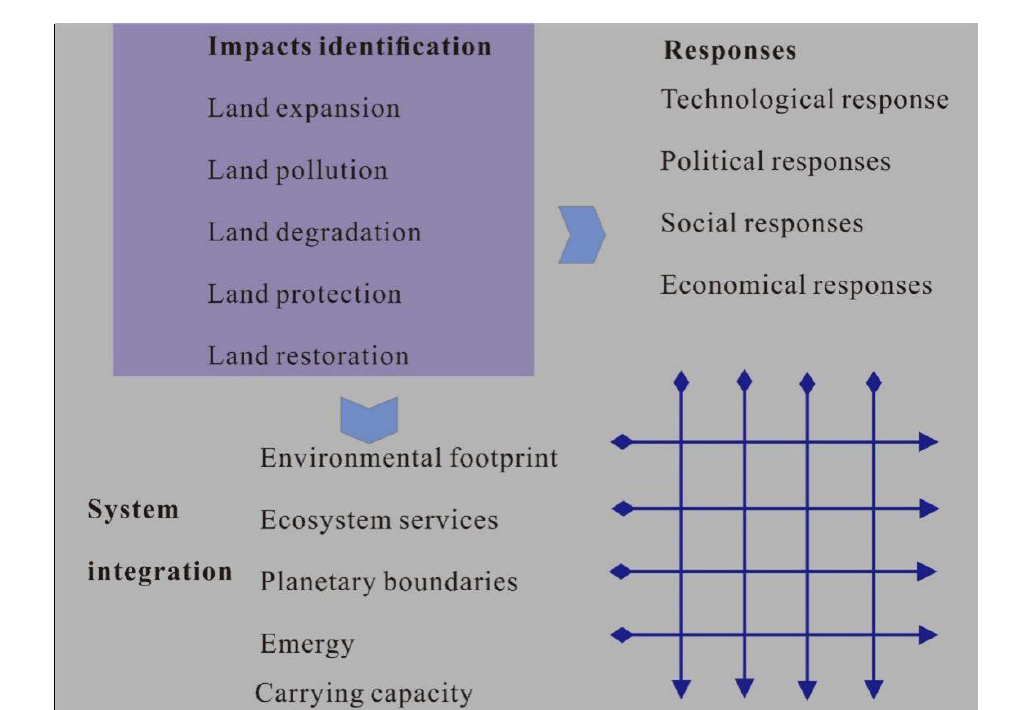
Figure 5. A framework to reduce undesirable impacts in the telecoupled systems, adapted from [89] .